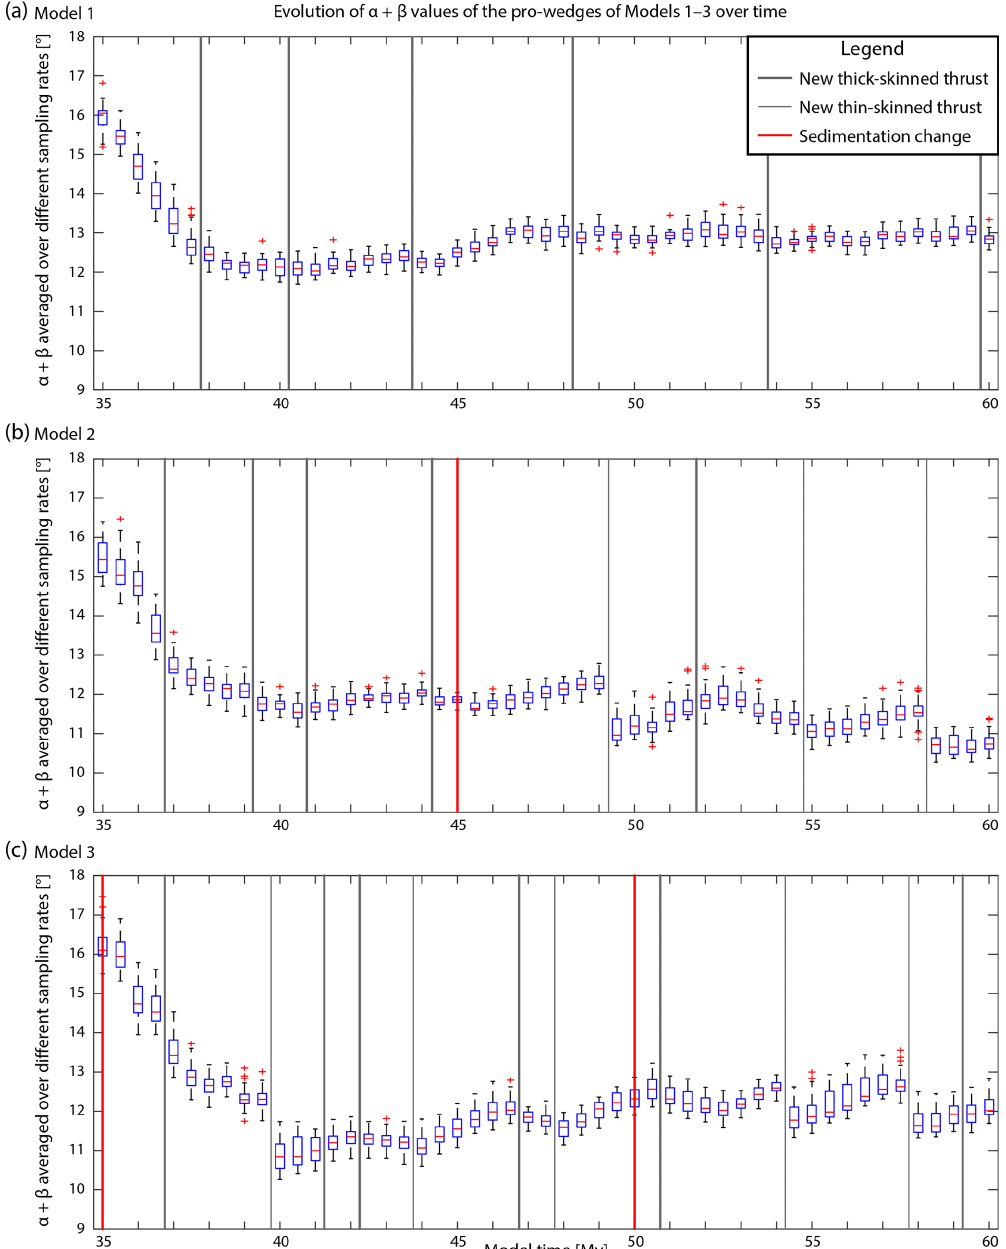
Figure 7. Plots of α + β vs. model time for Models 1 (a) , 2 (b) , and 3 (c) . For each time slice, the α and β values were determined using a range of sampling intervals. The box plots present the average α + β , α , and β values of these individual sampling intervals calculated for the entire wedge. On each box, the central mark is the median, the edges of the box are the 25th and 75th percentiles, and the whiskers extend to the most extreme data points considered not to be outliers. The outliers are plotted individually.